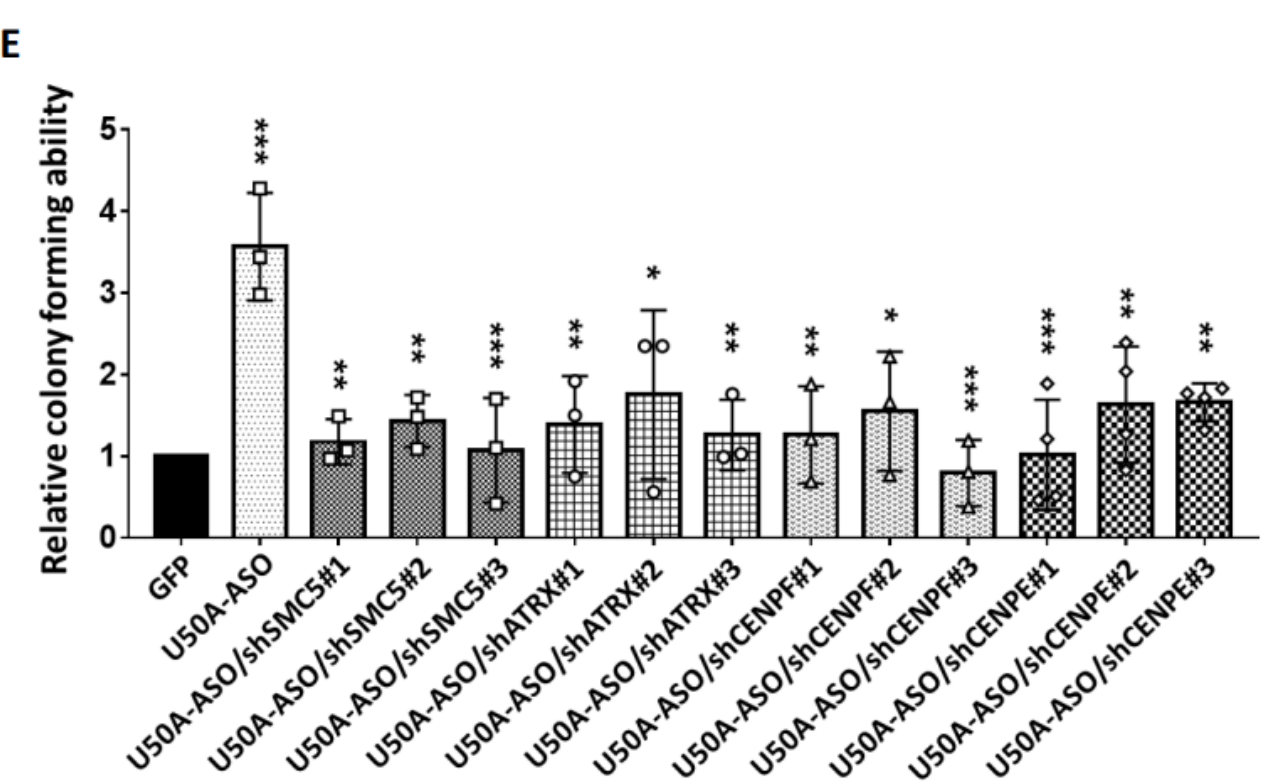
Figure 4. Effects of U50A on mitosis and colony-forming ability of breast cancer cells. Nocodazole (100 nM) was used to treat U50A-overexpressing MCF-7 cells for 14 h and was removed at the indicated time points. Cells were collected and subjected to immunofluorescence. ( A ) Representative images of immunofluorescence in U50A-overexpressing and control MCF-7 cells at the indicated time points. Yellow arrowheads indicate prometaphase cells, and red arrowheads indicate metaphase/anaphase cells. ( B ) Quantitated results of prometaphase, metaphase, and anaphase cells from immunofluores- cence images. Colony forming ability of breast cancer cells expressing U50A ( C ) and inhibiting U50A ( D ) were assayed. ( E ) Specific shRNAs were used to inhibit CENPE/F, ATRX, and SMC5 in U50A-inhibiting BT-474 cells and colony forming capacity were assayed. Data are represented as the mean ± SD ( n ≥ 3). * p < 0.05, ** p < 0.01, *** p < 0.001.